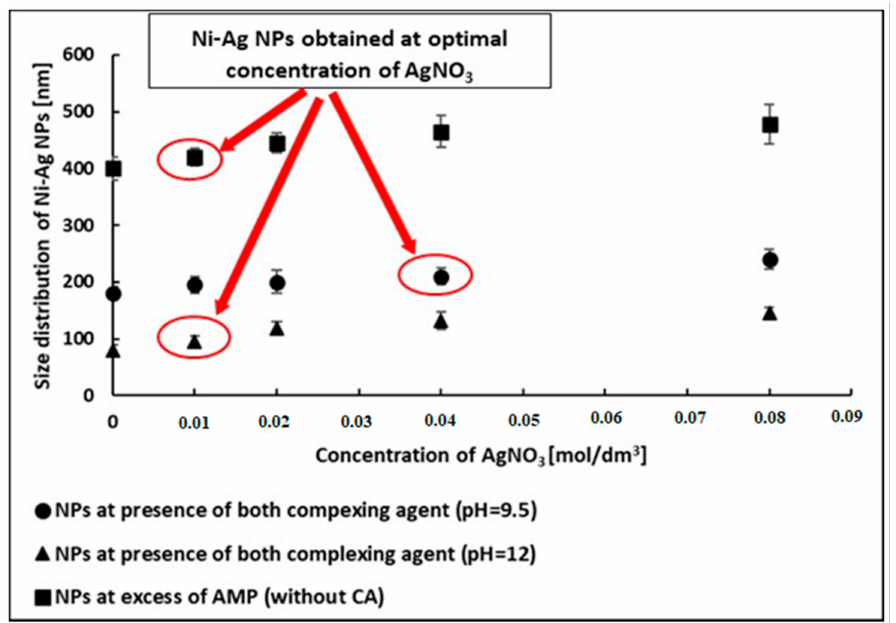
Figure 3. The dependence of the size of Ni-Ag NPs on the concentration of AgNO 3 in the reaction mixture. Ni-Ag NPs obtained at the optimal concentration of AgNO 3 are marked by red circles.